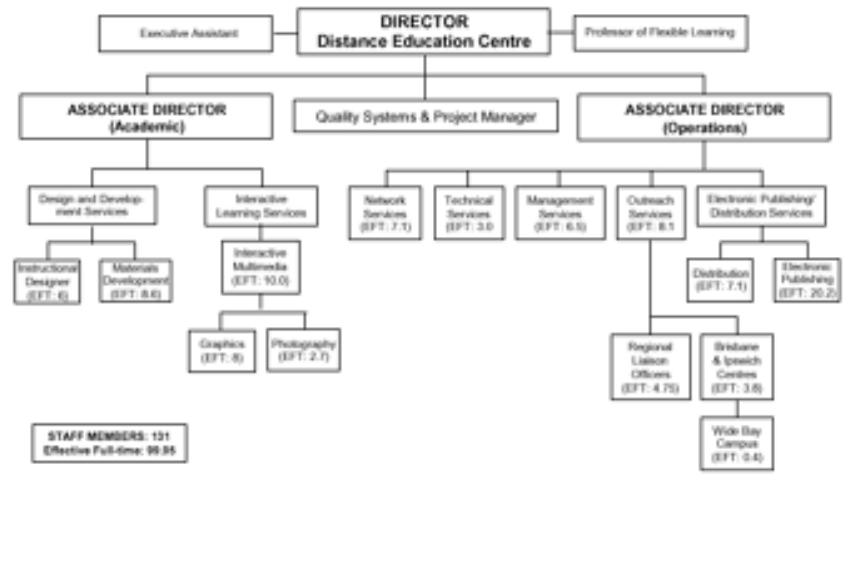
Figure 2: Staff Establishment of the USQ Distance Education Centre